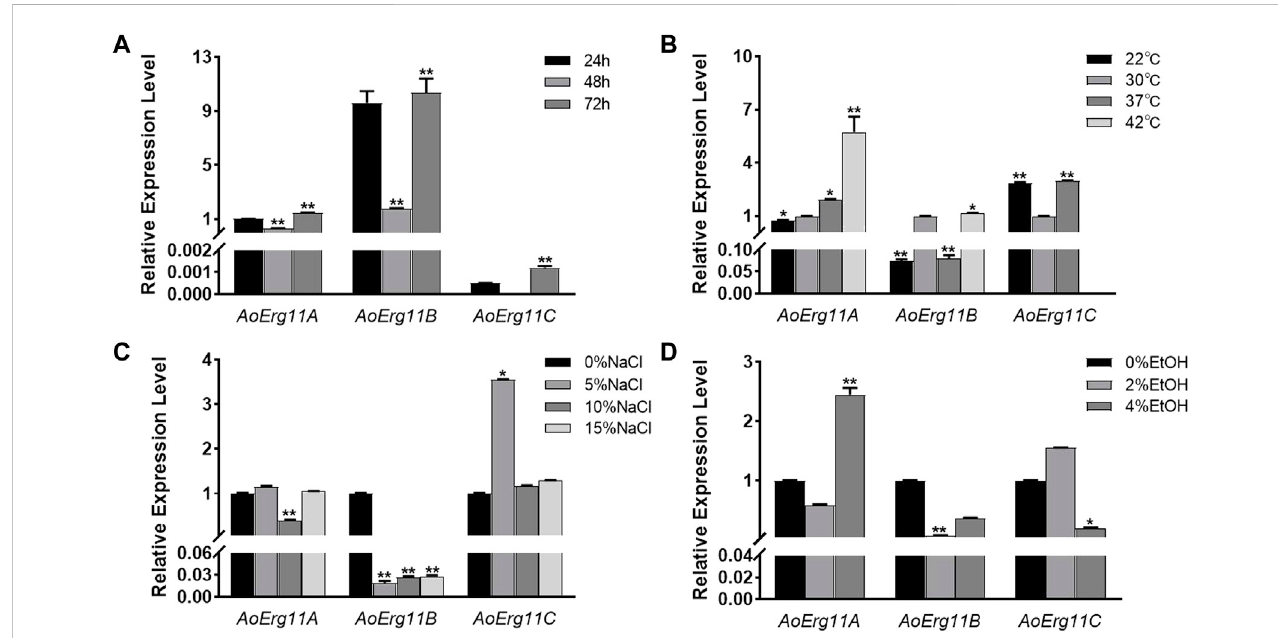
FIGURE 2 Expression levels of AoErg11A – AoErg11C at different growth times and under different abiotic stresses on CD medium. (A) Expression of AoErg11A – AoErg11C at 24, 48, and 72 h of growth; (B – D) Expression of AoErg11A – AoErg11C under temperature, salt and ethanol (EtOH) stress conditions. Wild-type A. oryzae spores were cultured in CD agar medium alone or CD agar medium supplemented with NaCl or ethanol at 30 ° C (except for temperature stress). The mycelia were harvested at 24, 48 and 72 h to determine the mRNA levels of AoErg11A – AoErg11C at different growth times. For other stress experiments, mycelia were collected at 72 h. The expression levels of corresponding genes at 24 h, 30 ° C and 0% NaCl/ethanol was used as control. Values represent the mean ± SD of three independent experiments. Statistical analyses were performed by t -test of GraphPad (*, p < 0.05; **, p < 0.01). For each experimental group, the relative expression level was compared to the corresponding control.